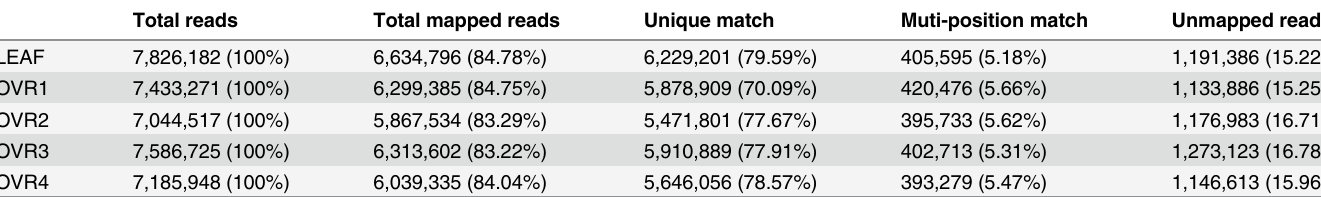
Table 1. Summary of the read numbers mapping to the rice genome based on the RNA-seq data. Total reads